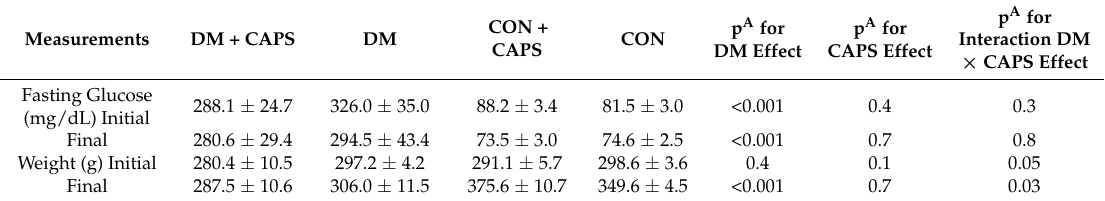
Table 1. Mean fasting glucose levels and body weights of experimental groups at the beginning and end of the experiment.